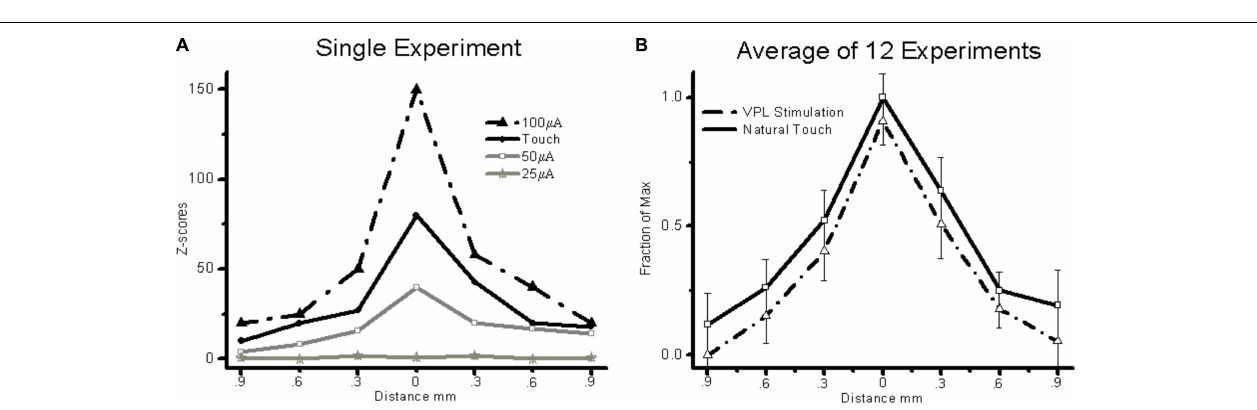
FIGURE 5 | VPL MiSt produces SFs comparable to natural touch in S1. (A) SFs produced via VPL-MiSt or touch from a single experiment. (B) Averaged stimulus fields from 15 natural touch and 7 bipolar VPL stimulation experiments. VPL-MiSt was at 75 µ A. Each group depicts a pyramidal stimulus field ± standard errors (error bars). Note the similarity between the two curves. All MiSt were biphasic bipolar pulses with each phase 200 µ sec long. The X -axis is the distance in mm between cortical electrodes.